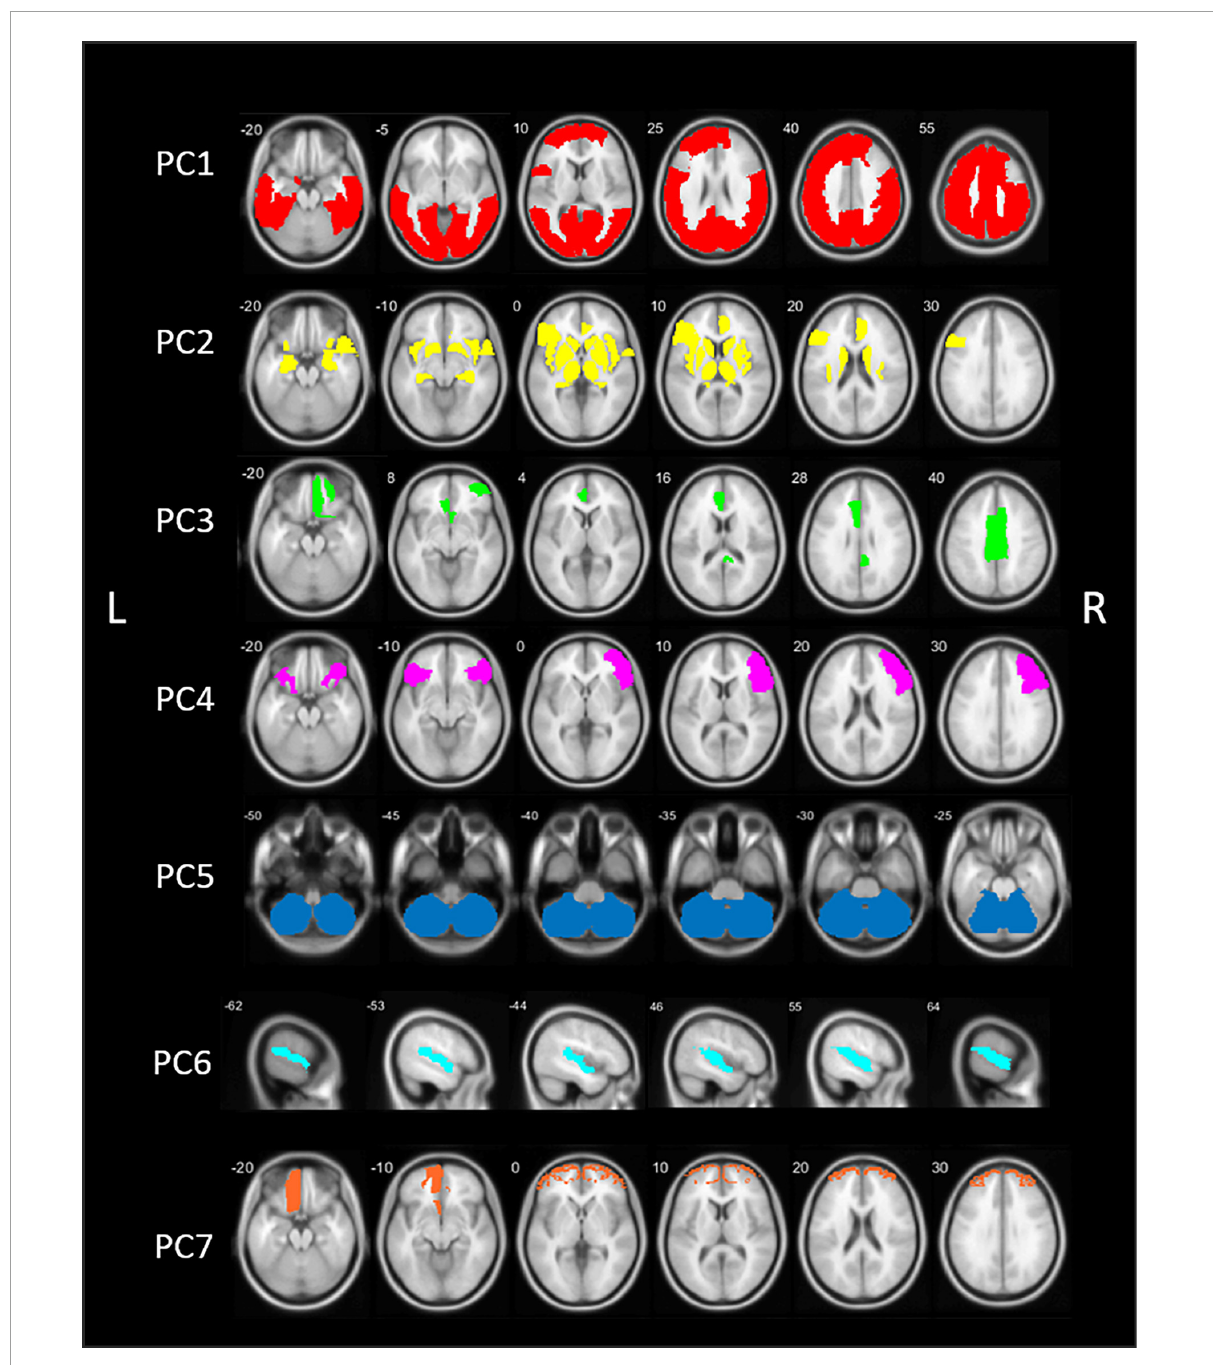
FIGURE2 Schematic representation of the seven principal components (PCs) of the principal component analysis (PCA) in healthy control (HC) subjects. PC, Principal component; L, left; R, right.